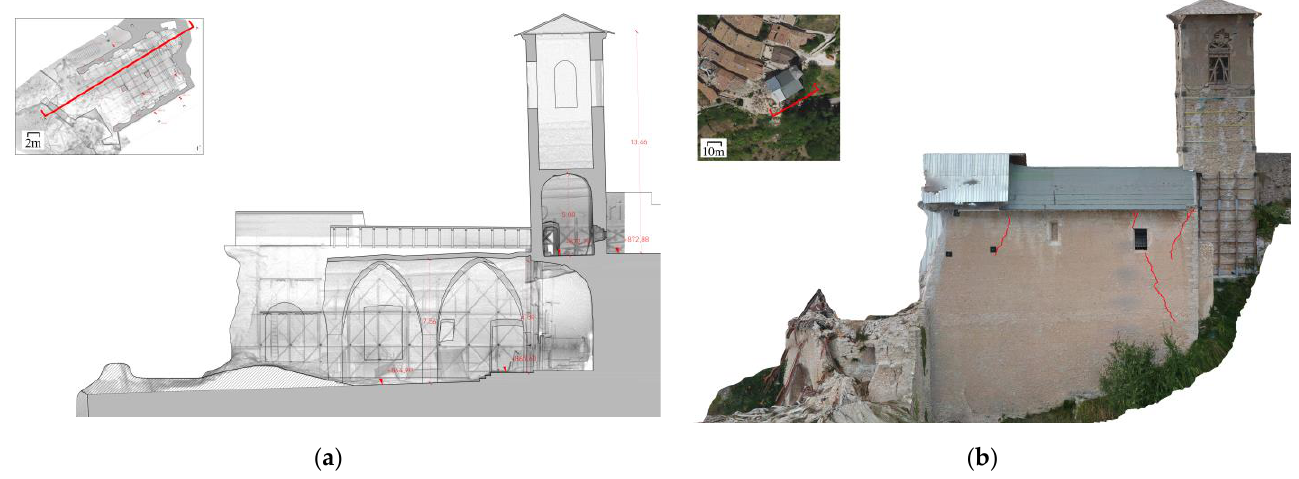
Figure 9. Examples of 2D digital products: ( a ) section; and ( b ) façade ortophoto for the Sant’Andrea.